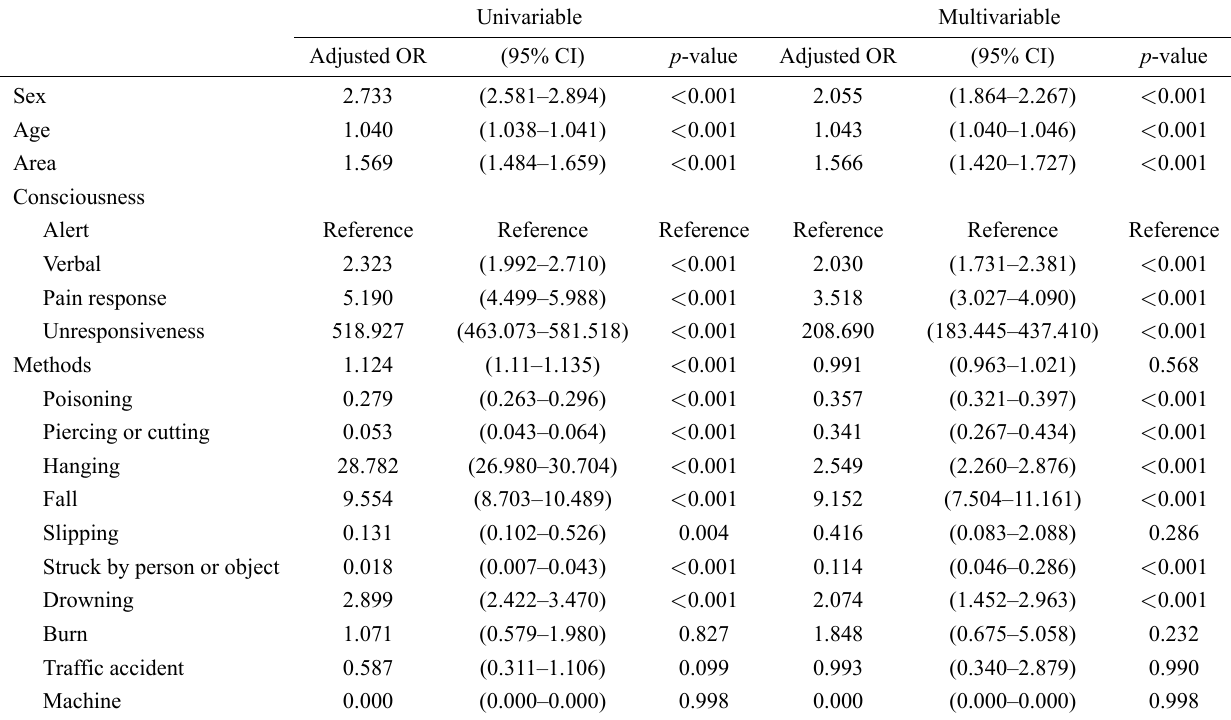
Table 4. Multivariable logistic regression analysis of factors affecting